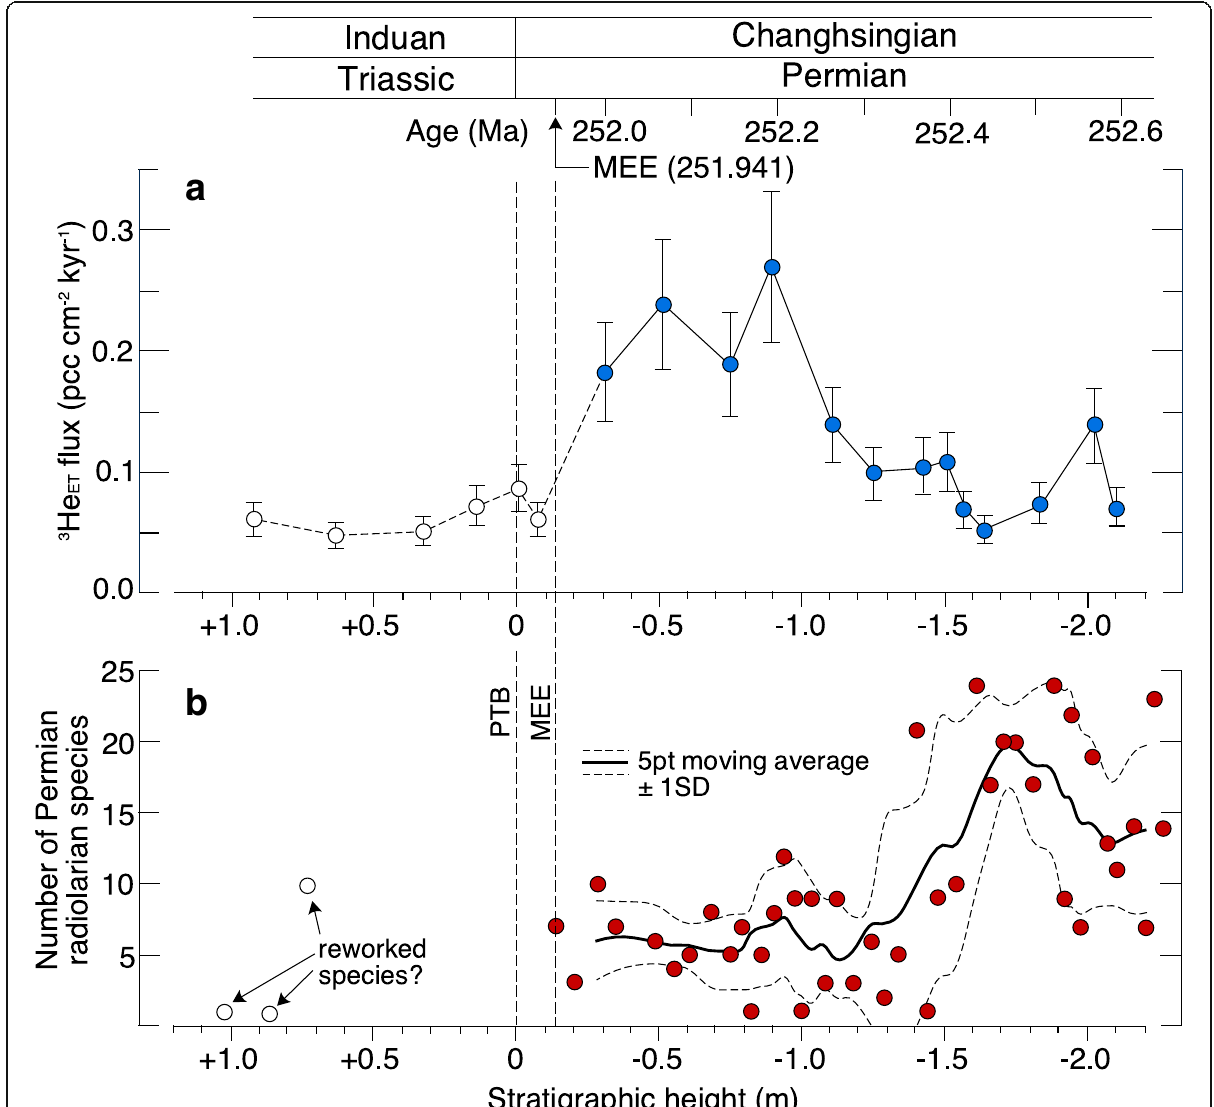
Fig. 7 Extraterrestrial 3 He ( 3 He ET ) flux and radiolarian species diversity across the PTB. a 3 He ET flux calculated from extraterrestrial 3 He concentrations (Table 1), a mean dry bulk density of 2.6gcm − 3 for claystone, and mean sedimentation rates calculated using astronomically tuned cyclostratigraphy. Error bars are based on two standard deviations calculated for the MAR of the Permian section. The 3 He ET flux after the MEE horizon was tentatively estimated assuming sedimentation rates remained stable after the MEE. See Table 1 for data. b Stratigraphic variation of the number of Permian radiolarian species in the study section (Sano et al. 2012a). Marked decline in the diversity of Permian radiolarians began at ~500 kyr prior to the PTB. Permian radiolarians in the Triassic section are regarded as reworked species (Sano et al.